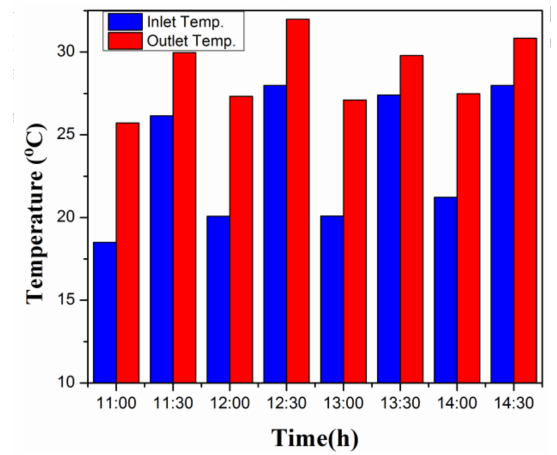
Figure 15. Inlet and outlet water temperature for